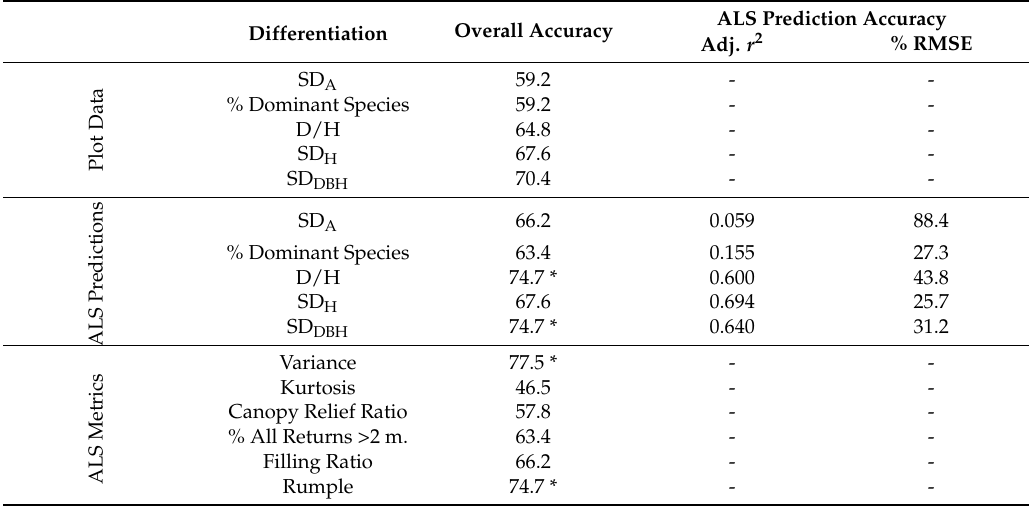
Table 5. Accuracy of bimodal plots classification using ground measurements, ALS predictions, and corresponding ALS